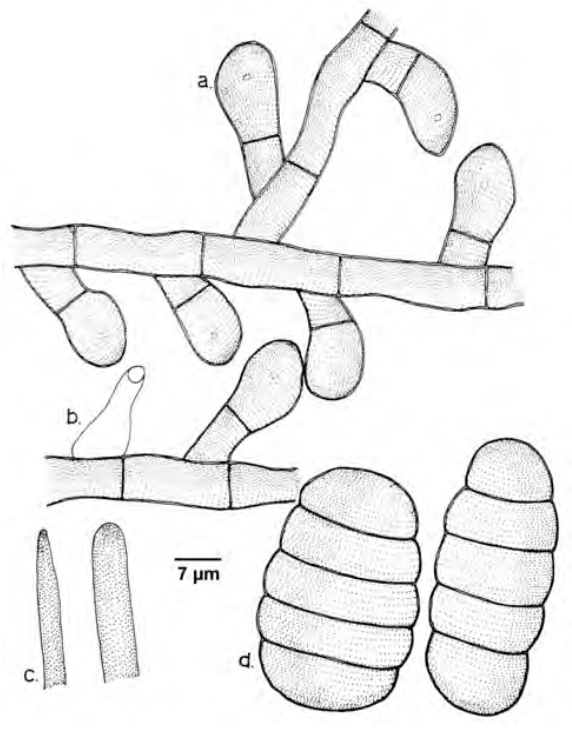
Figure 92. Meliola machili a - Appressorium; b - Phialide; c - Apical portion of mycelial setae; d - Ascospores